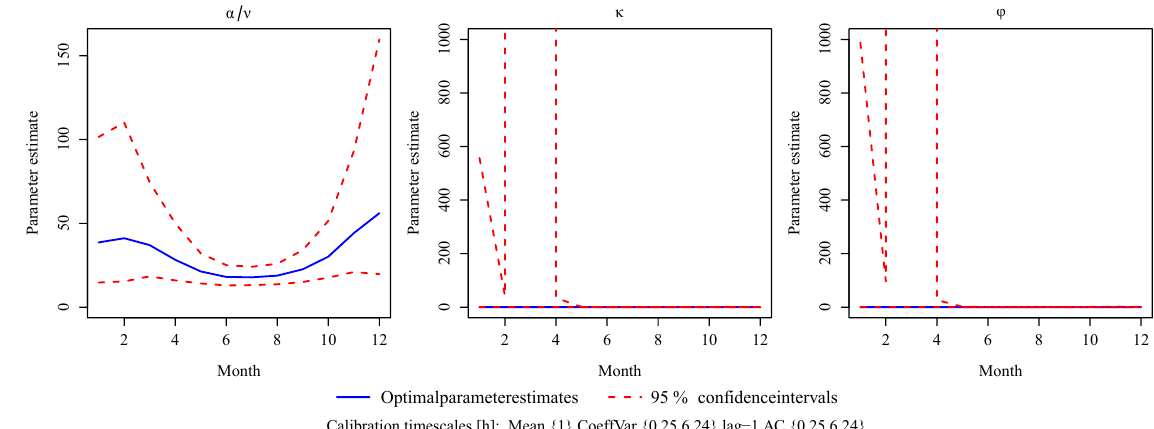
Figure 11. Fitted model parameters for the BL1M model with a 1.5mm censor applied to Bochum 15min data. Table 3. Proportion of maximum rainfall and number of independent peaks per year for the selected censors given in Table 2. Scale (min) Bochum Atherstone Proportion of maximum